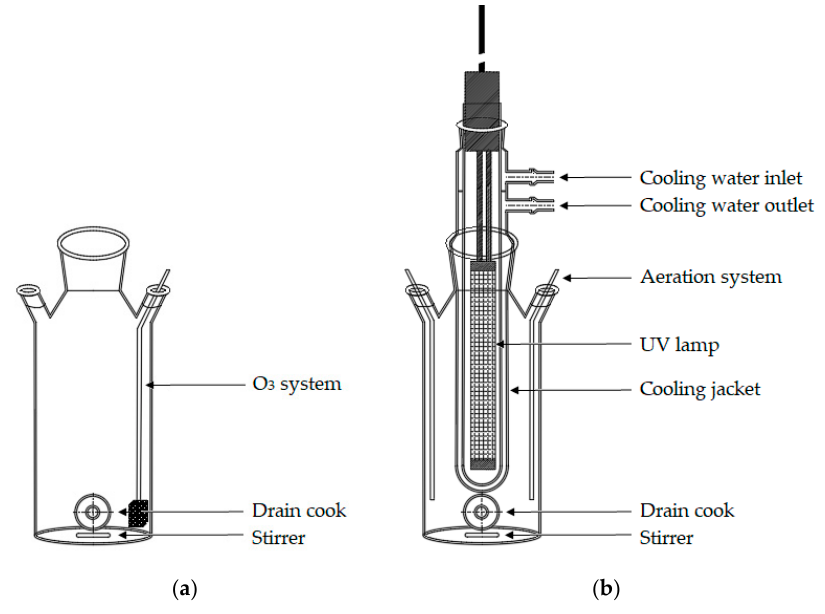
Figure 1. Reactor for the ( a ) H 2 O 2 , O 3 , and ( b ) UV, UV/TiO 2 [21] processes.